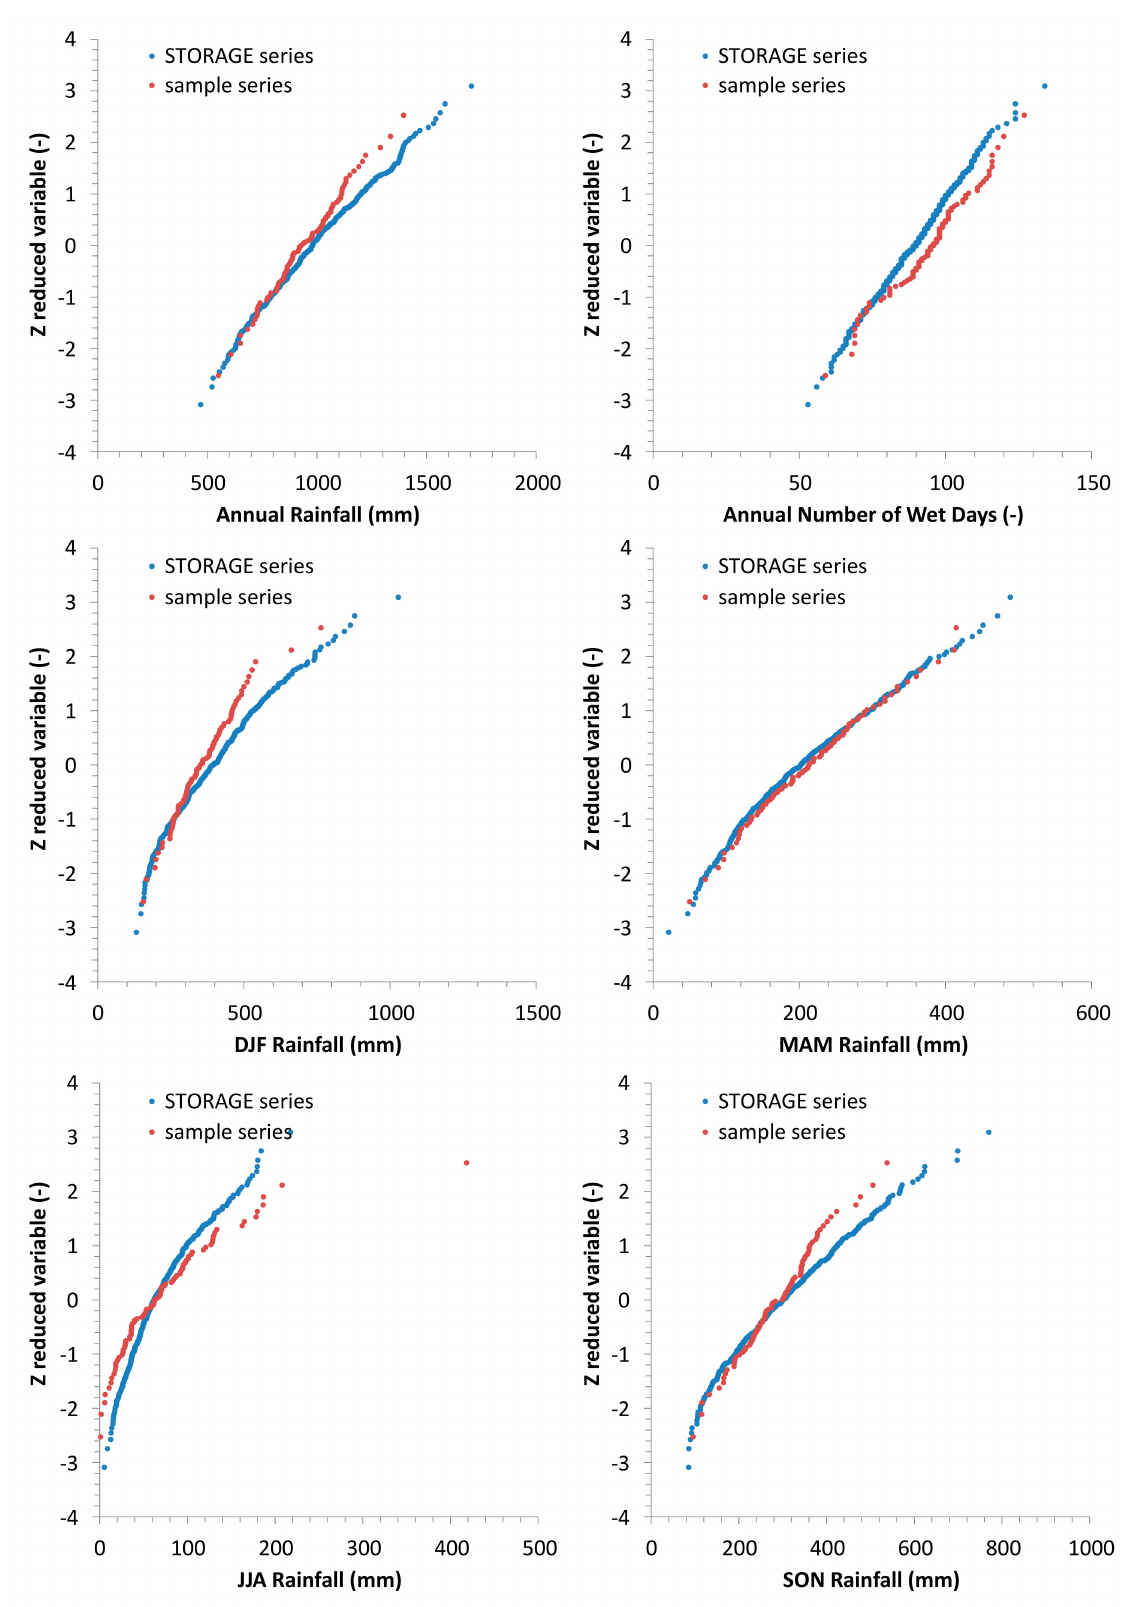
Figure 21. Vibo Valentia rain gauge: Gaussian probabilistic plots, showing the comparison among synthetic and observed series, regarding annual and seasonal rainfall, and annual number of wet